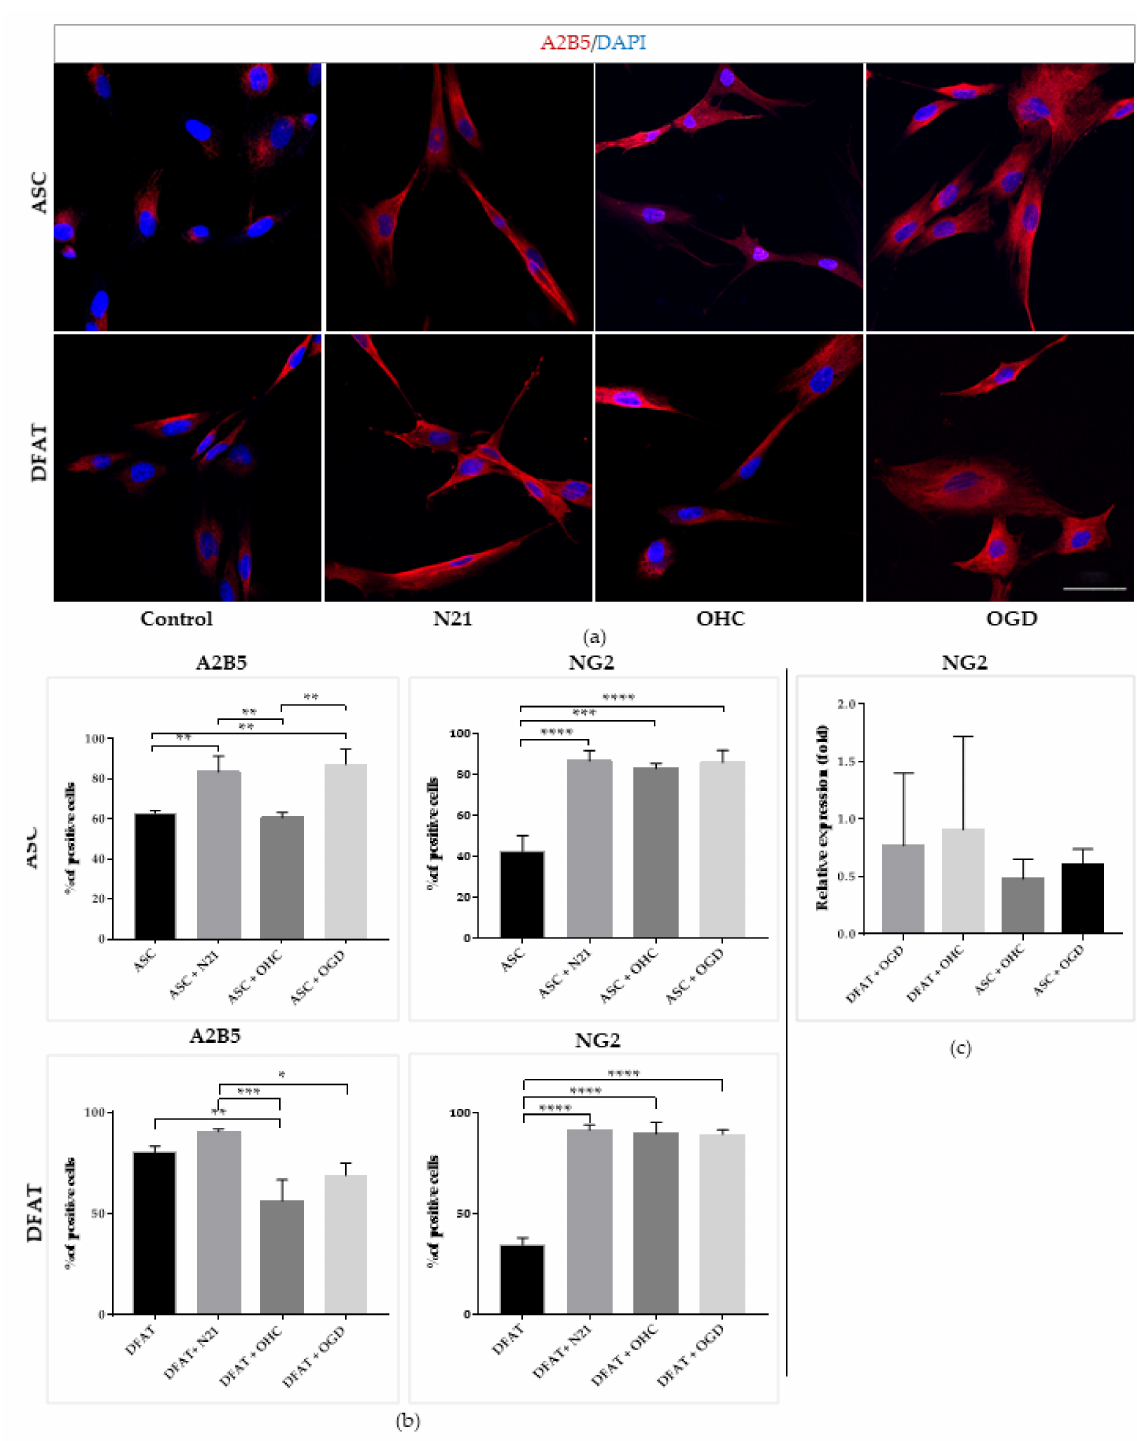
Figure 10. Oligodendrocytic differentiation of ASCs/DFAT cells. A2B5,NG2 immunocytochemical/expression analysis. ( a ) Immunofluorescent images of ASCs/DFAT cells A2B5 staining; ( b ) Quantitative analysis of oligodendrocytic markers (A2B5, NG2) presence in different culture conditions; ( c ) Oligodendrocytic marker NG2 expression. The results are presented as mean values of three experiments ± SEM. The differences were considered statistically significant when p -value <0.05. Statistical significance level * for 0.01 < p < 0.05; ** for 0.001 < p < 0.01; *** for 0.0001 < p < 0.001; **** for p <